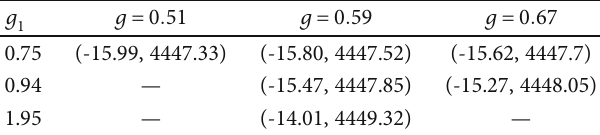
— — ð Me V Þ , M ð MeV ÞÞ for P ð 4380 Þ and g = 0 : 75 . Table 2: ð E 1 B P c c